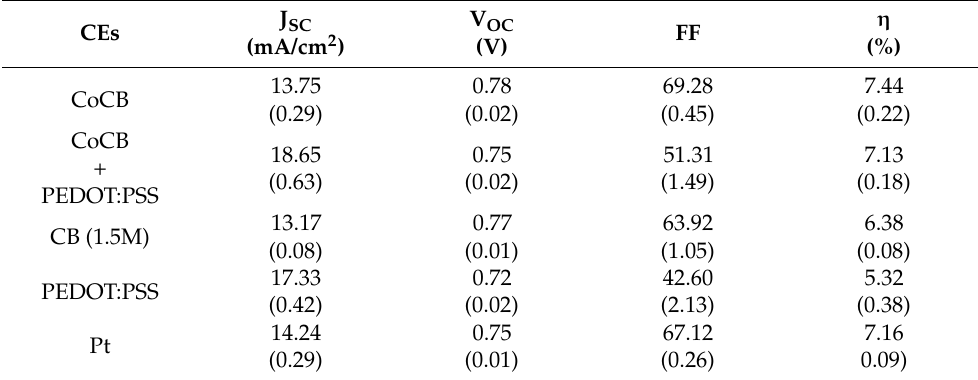
Table 3. Performance levels of DSSCs with cobalt complex CEs. The values in the brackets are the standard